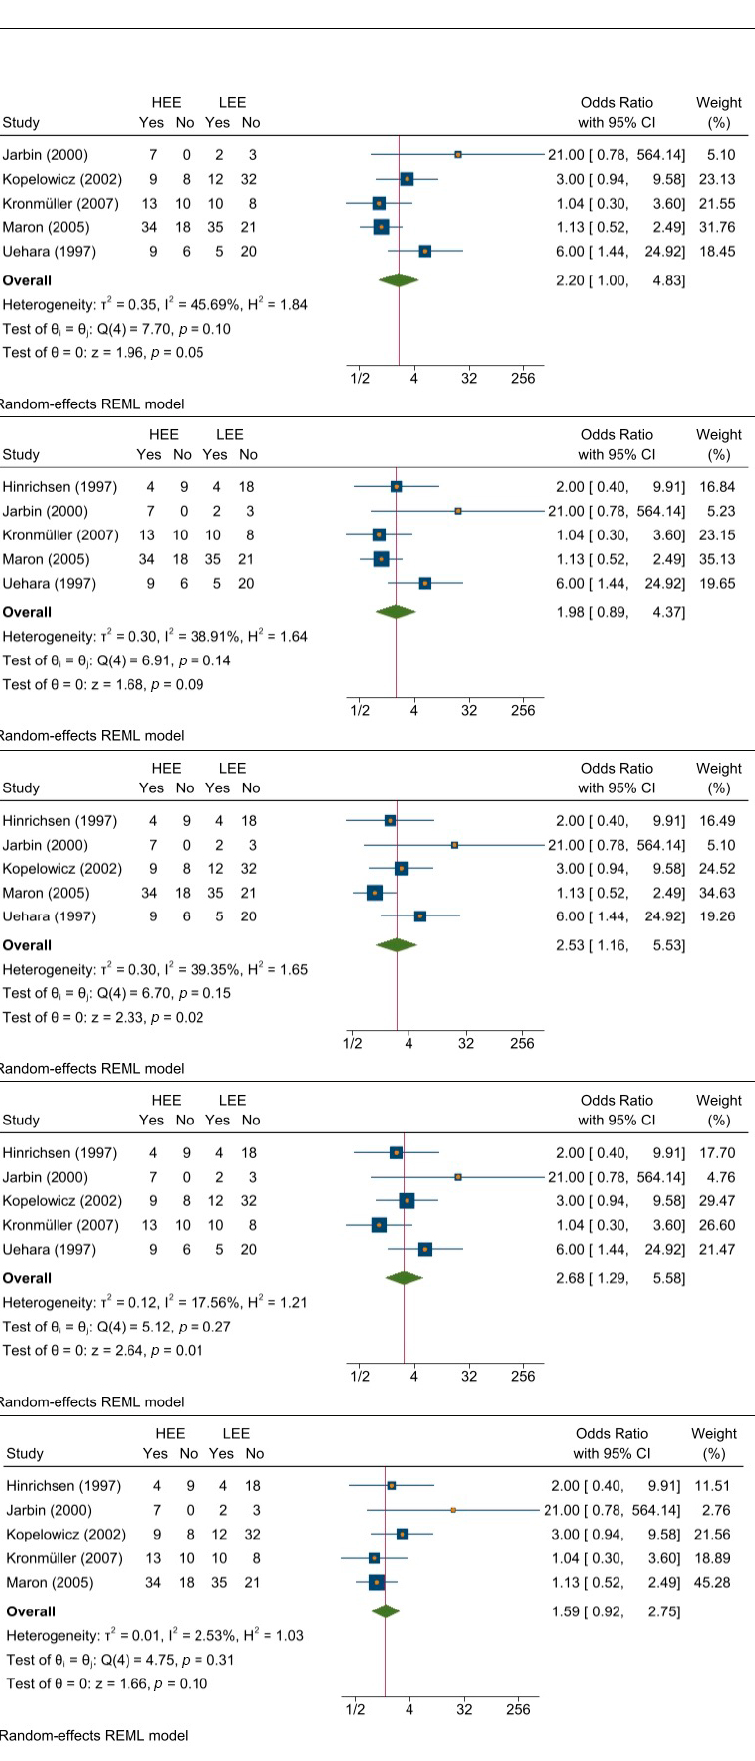
Figure 5. Leave ‐ one ‐ out meta ‐ analysis [35,37–41]. Figure 5. Leave-one-out meta-analysis